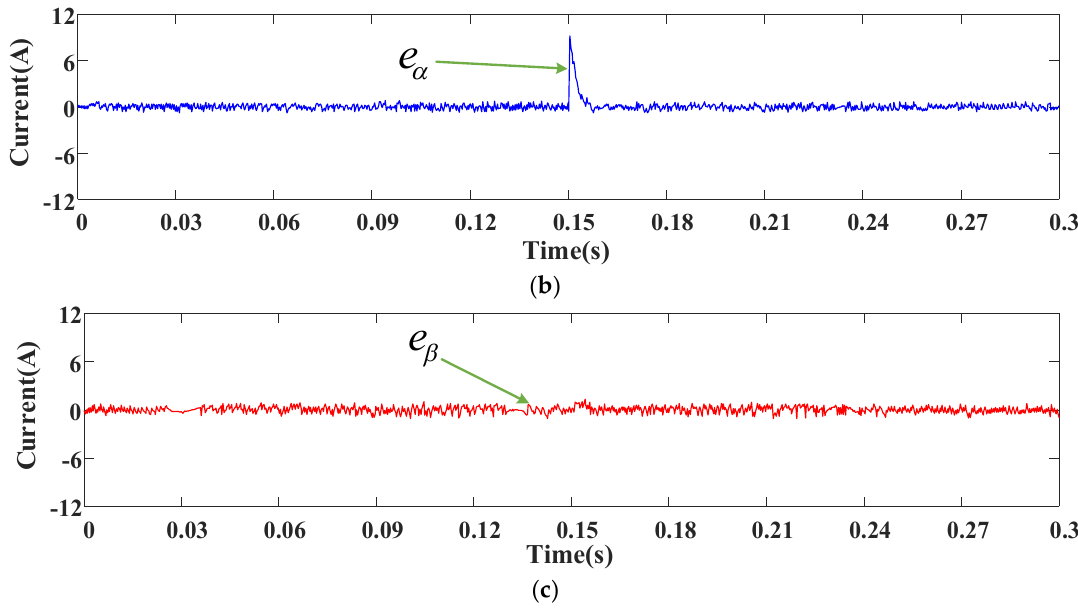
Figure 26. Experimental results of SVV-MFPCC following a sinusoidal current command with current reversed at 0.15 s under frequency 10 Hz (case 5): ( a ) current responses; ( b ) α -axis current error; ( c ) β -axis current error.